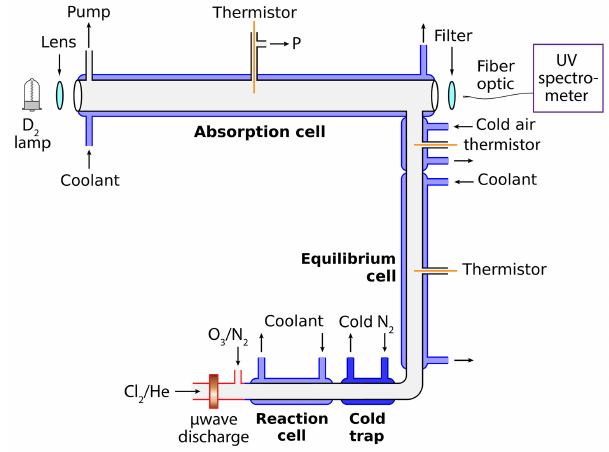
Figure 1. Schematic of the discharge-flow absorbance experiment. Dilute chlorine gas in helium flows through a microwave discharge to form Cl radicals. Dilute ozone in nitrogen is then injected to pro- duce ClO radicals. Self-reaction of ClO occurs in the cold reaction cell to form ClOOCl. When utilized, the cold trap provides for halo- gen oxide purification. ClO / ClOOCl equilibrium is established in the equilibrium cell, which is held at the same temperature as the absorption cell. The gas mixture is then characterized via UV spec- troscopy in the absorption cell using software developed in-house.